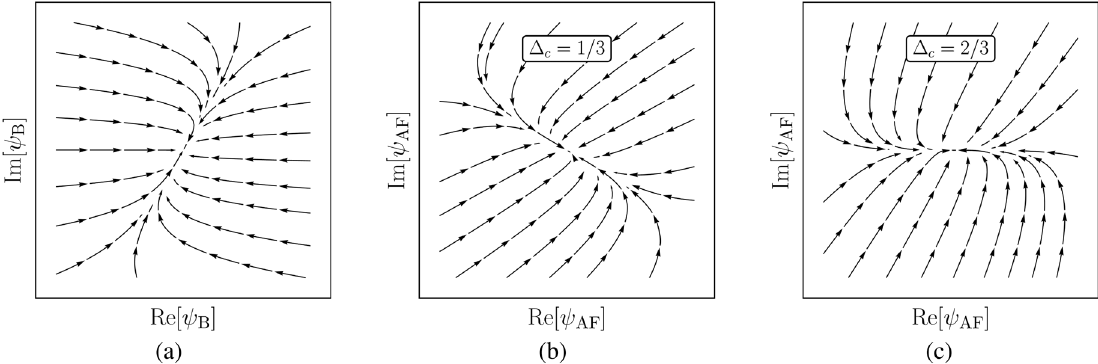
; ϕ 0 ) relaxation of i i AF for AF